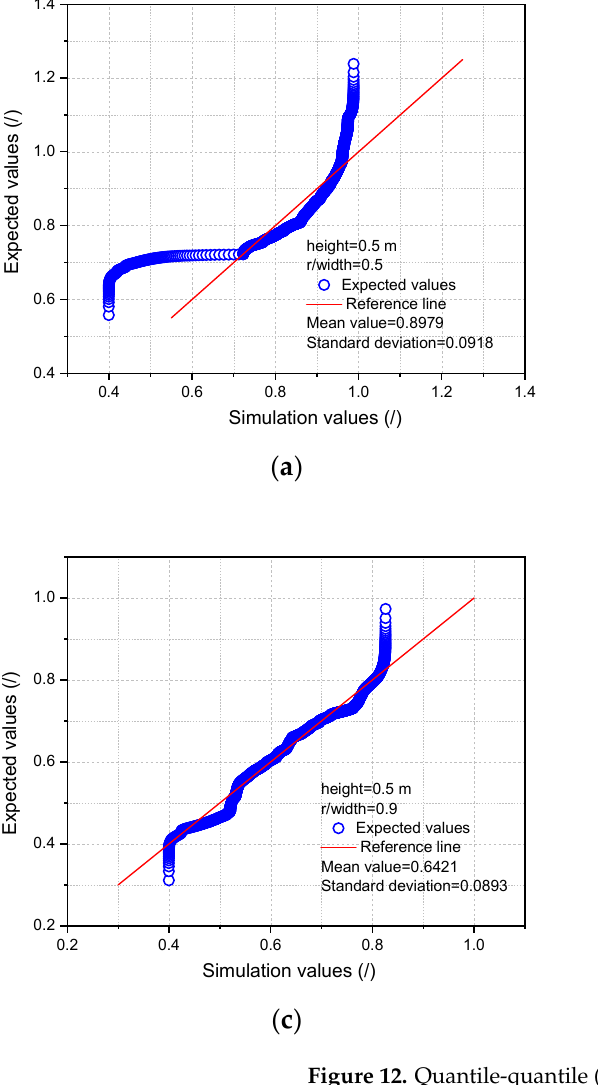
Figure 12. Quantile-quantile (Q-Q) plots of central and wall porosity of particles used in experiment at the height of 0.24 m and 0.5 m, r/Width = 0.5 and 0.9, ρ p = 2700 kg/m 3 . ( a ) central distribution, 0.5 m; ( b ) central distribution, 0.24 m; ( c ) wall distribution, 0.5 m; ( d ) wall distribution, 0.24 m.